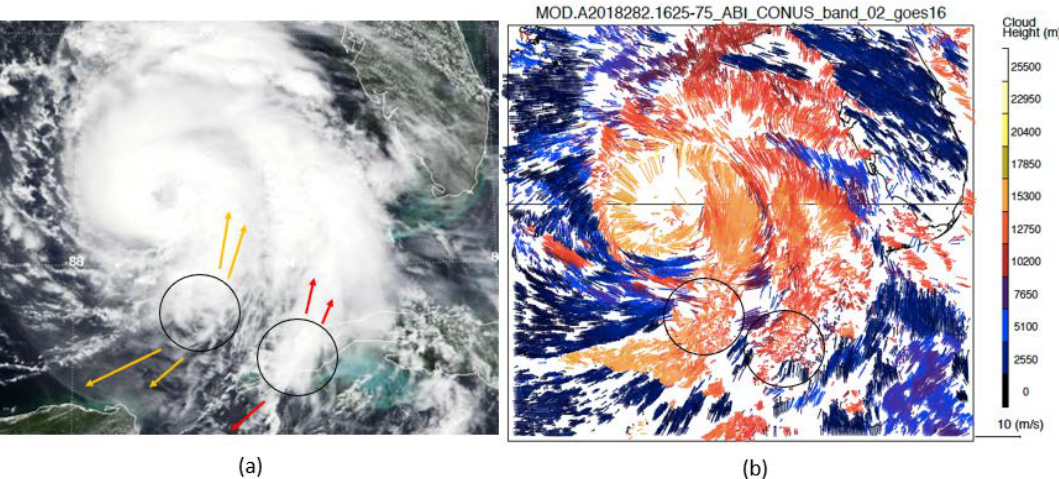
Figure 28. ( a ) MODIS image of Hurricane Michael on October 9, 2018 with the circles indicating deep convective zones and the arrows for wind direction. ( b ) Retrieved AMVs from ABI band 2 with height in color. The circles highlight small AMV wind speeds at high altitudes.